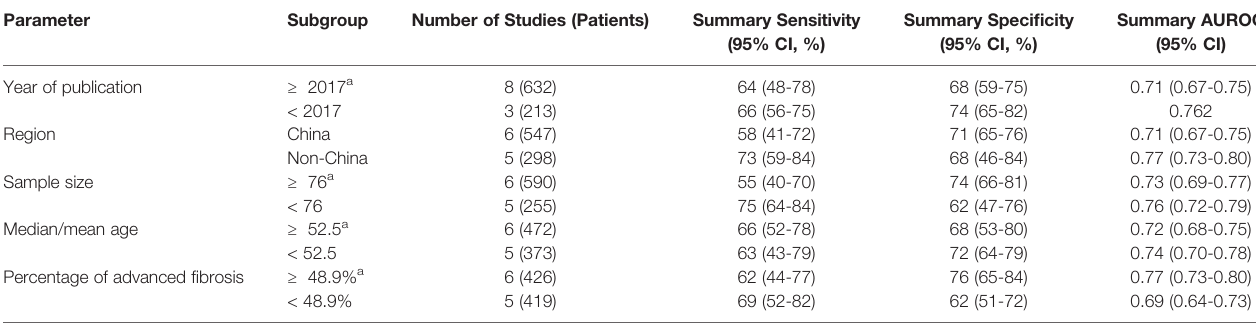
TABLE 5 | Subgroup analysis of FIB-4 in prediction of advanced fi brosis. Parameter Subgroup